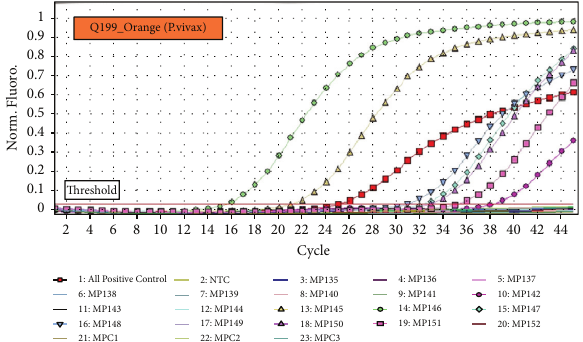
Figure 5: qPCR amplification of blood samples infected by Plasmodium vivax . All Malaria-positive control � positive control provided in a commercial kit. NTC � negative test control (phosphate buffer saline).